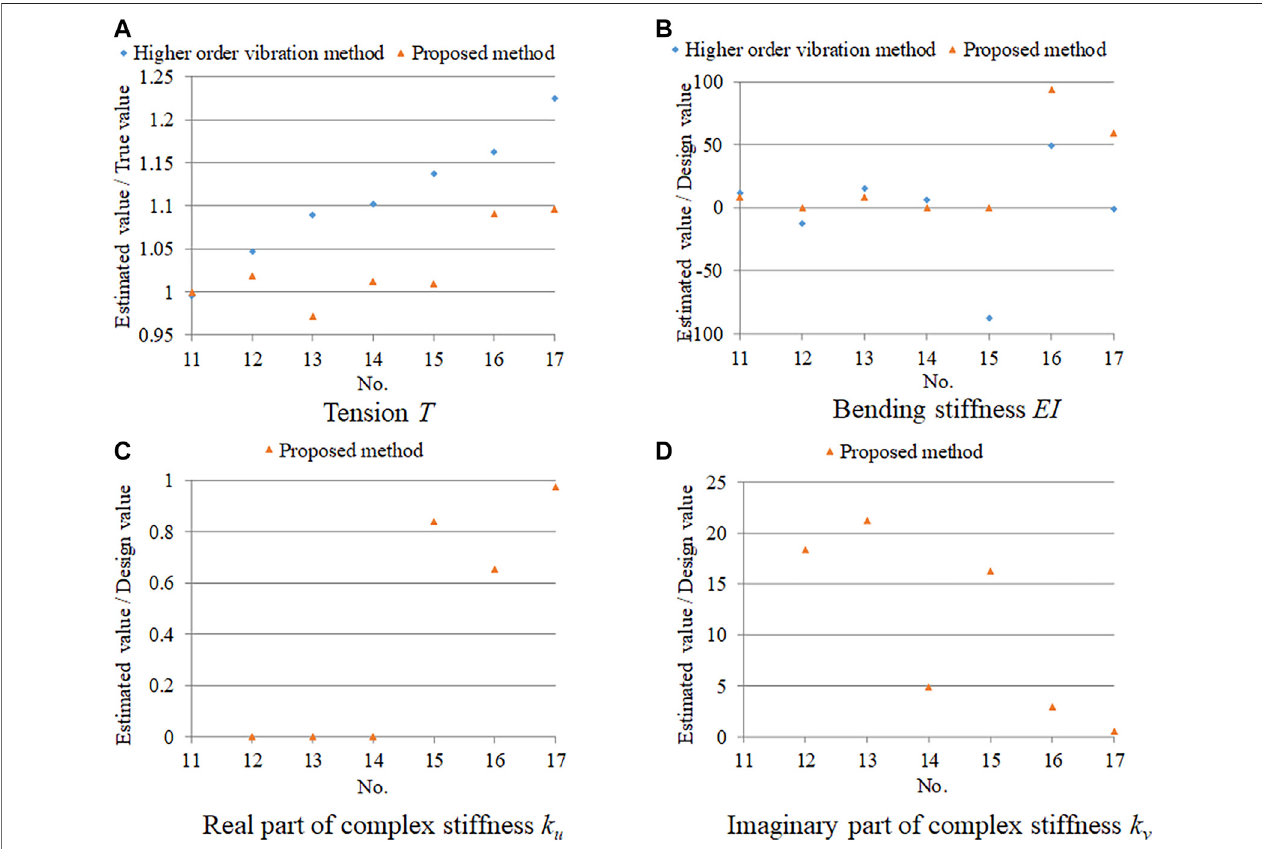
FIGURE 11 | Estimation accuracy for Nos. 11 – 17 (180 kN): (A) tension; (B) bending stiffness; (C) real part of complex stiffness; (D) imaginary part of complex stiffness.